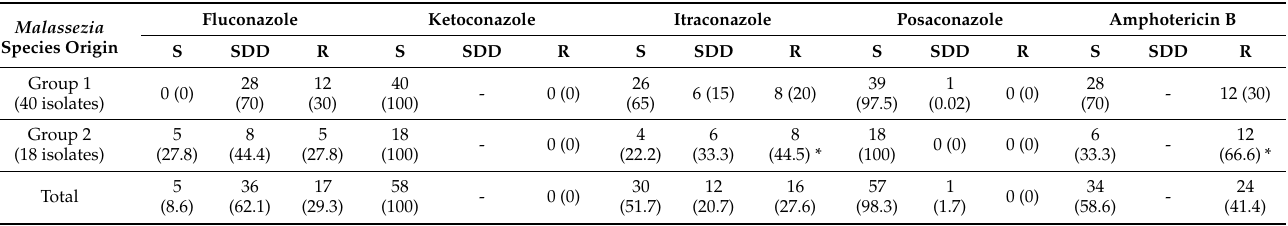
Table 3. Interpretive antifungal susceptibility classification of Malassezia isolates according to the clinical origin into susceptible (S), susceptible dose-dependent (SDD), and resistant (R). Number of isolates (and percentage) by category.